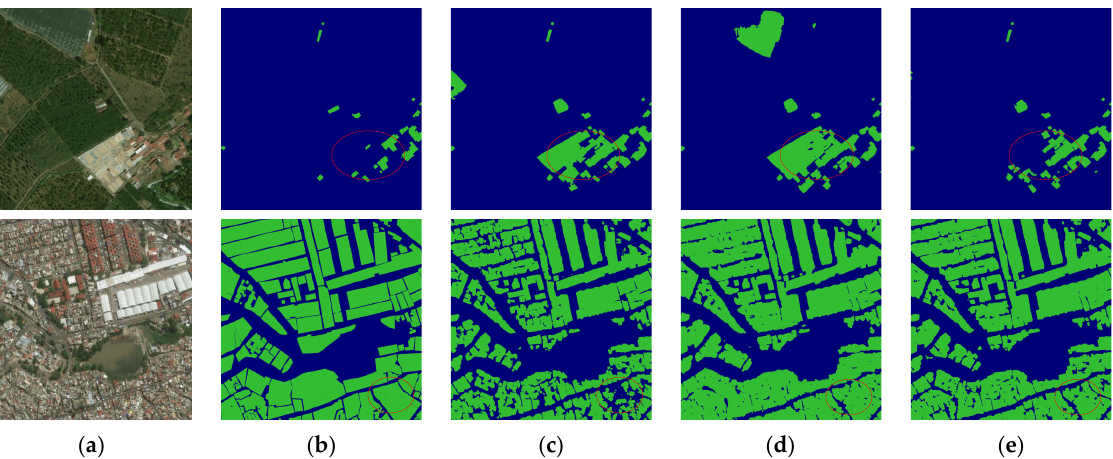
Figure 7. Visual examples of segmentation results in Stage 1. ( a ) shows pre-disaster images; ( b ) shows ground truth; ( c , d ) are the results of RescueNet and MaskRCNN, respectively; ( e ) is the segmentation result of our proposed